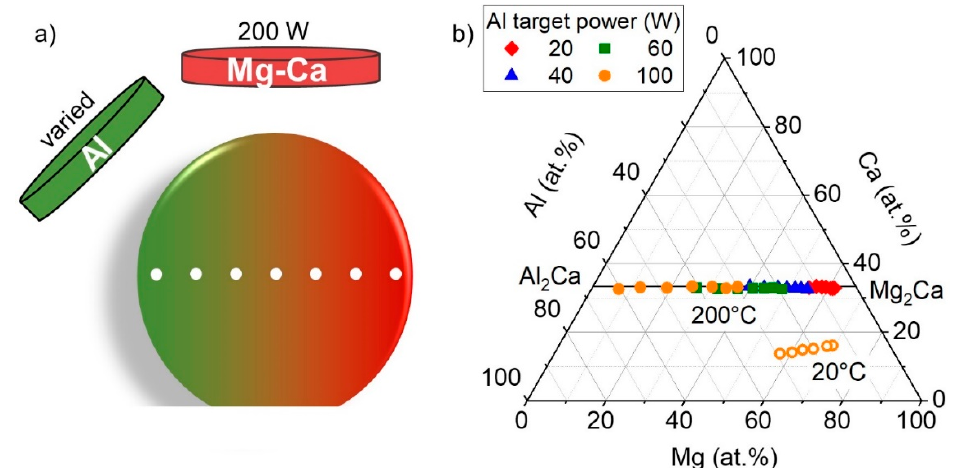
Figure 3. ( a ) Schematic representation of the deposition setup for combinatorial Mg–Ca–Al thin film deposition with varying Al target power. ( b ) Measured chemical composition by EDX along the chemical gradient for samples synthesized at room temperature (approximately 20 °C) and 200 °C.